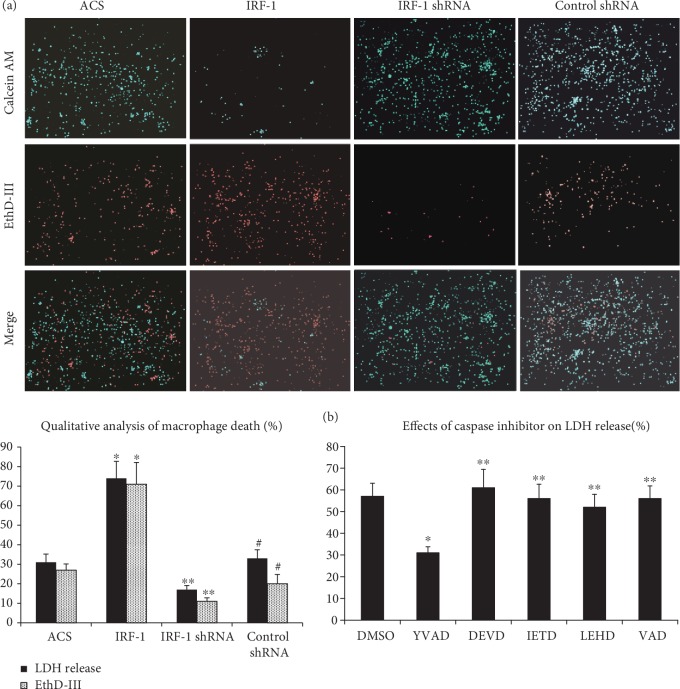
IRF-1-induced macrophage pyroptosis is caspase-1 dependent. Cell death was visualized by EthD-III (red)/calcein AM (green) staining (100x) or LDH release. (a) Qualitative analysis of cell lysis expressed as the percentage of EthD-III-positive cells or LDH release in the total cells. ∗ indicates vs ACS and control shRNA group (∗p < 0.01). ∗∗ indicates vs ACS and control shRNA group (∗p < 0.05). # indicates vs ACS group (#p < 0.05). (b) Cells were treated with DMSO or caspase inhibitors (Ac-YVAD-CHO for caspase-1, Ac-DEVD-CHO for caspase-3, Z-IETD-CHO for caspase-8, Ac-LEHD-CHO for caspase-9, and z-VAD-CHO for pan-caspase). ∗ indicates vs DMSO group (∗p < 0.01). ∗∗ indicates vs DMSO (∗∗p < 0.05).